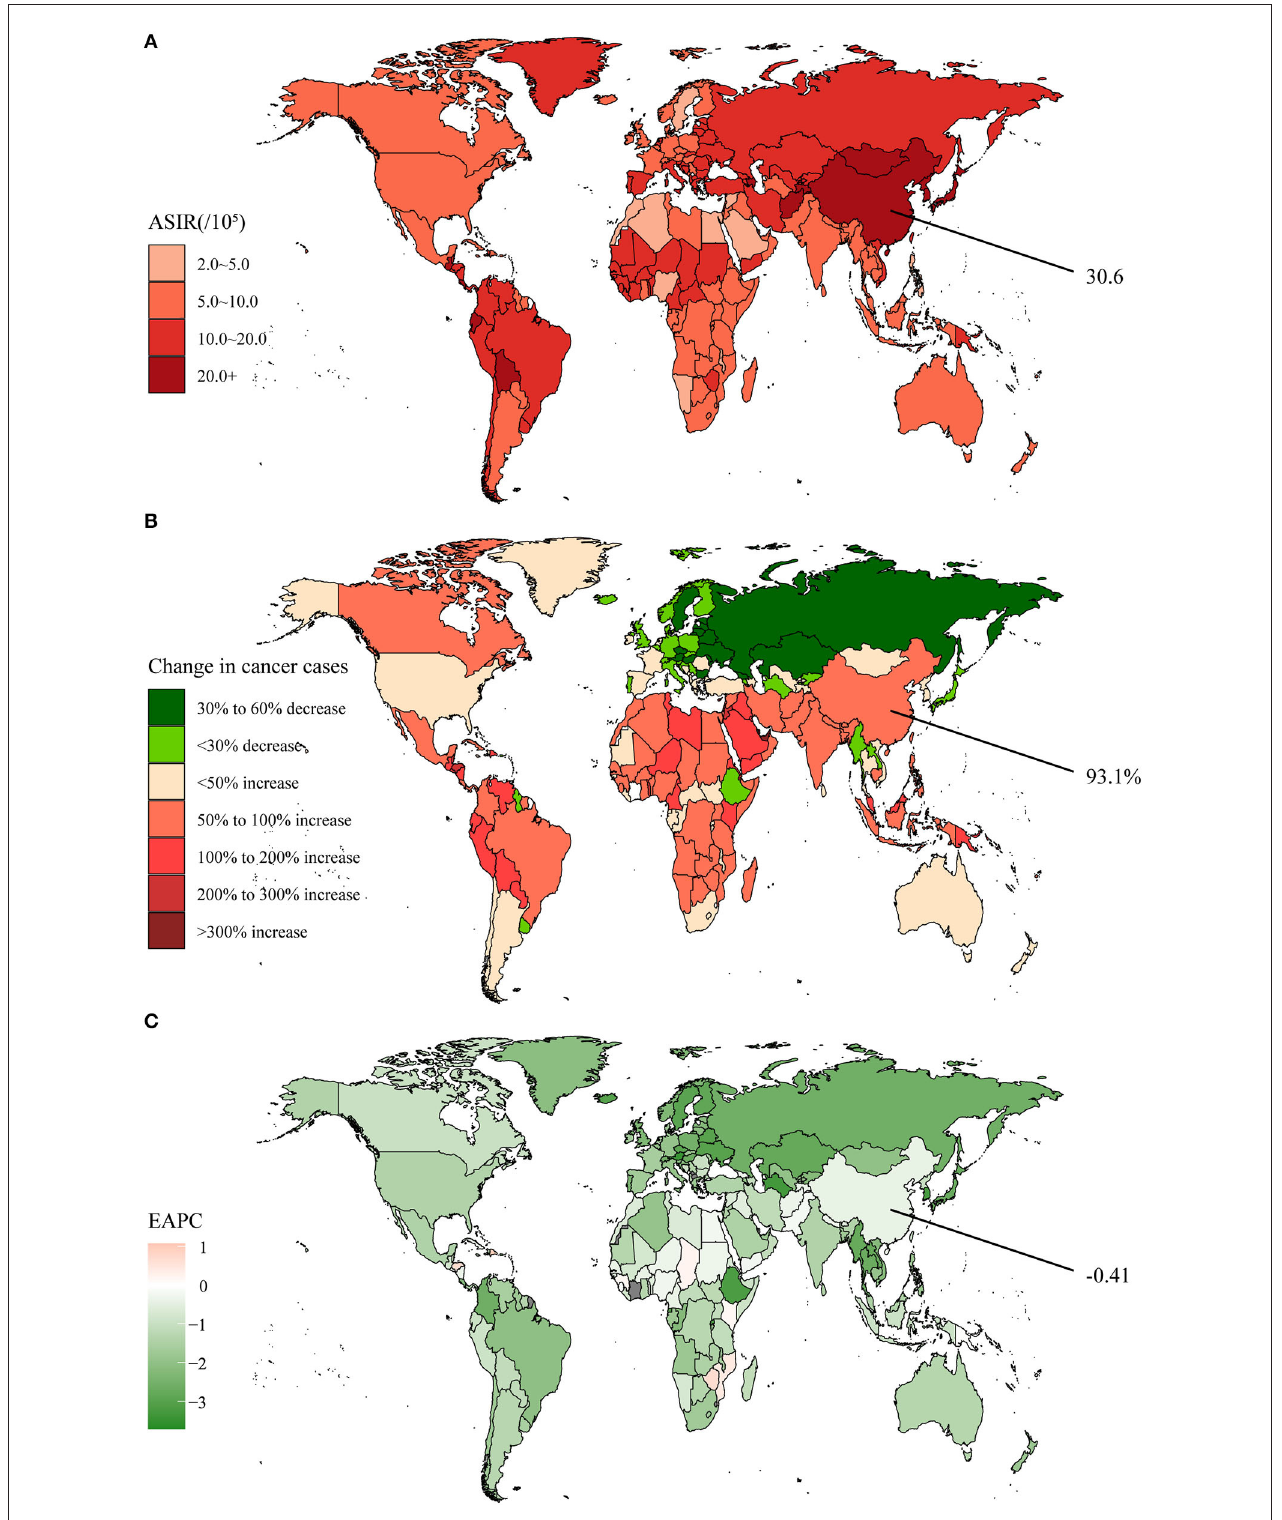
FIGURE 2 | The global disease burden of stomach cancer in 204 countries and territories. (A) The ASIR in 2019; (B) The relative change in incident cases between 1990 and 2019; (C) The EAPC of ASIR from 1990 to 2019. Outcomes of China were specifically annotated. ASIR, age-standardized incidence rate; EAPC, estimated annual percentage